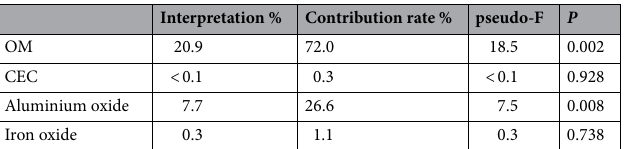
Table 8. Redundancy analysis parameters for sediment components involved in adsorption.